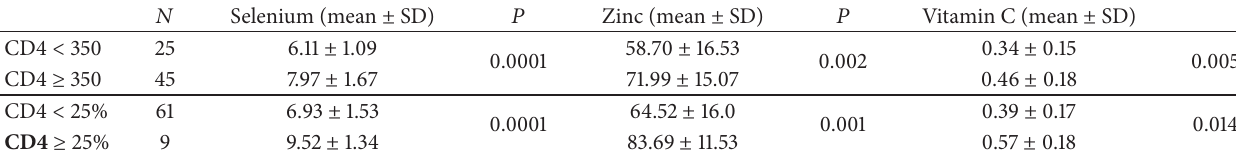
Table 2: Relationship between the mean serum micronutrient levels and CD4 categories of the HIV infected subjects.